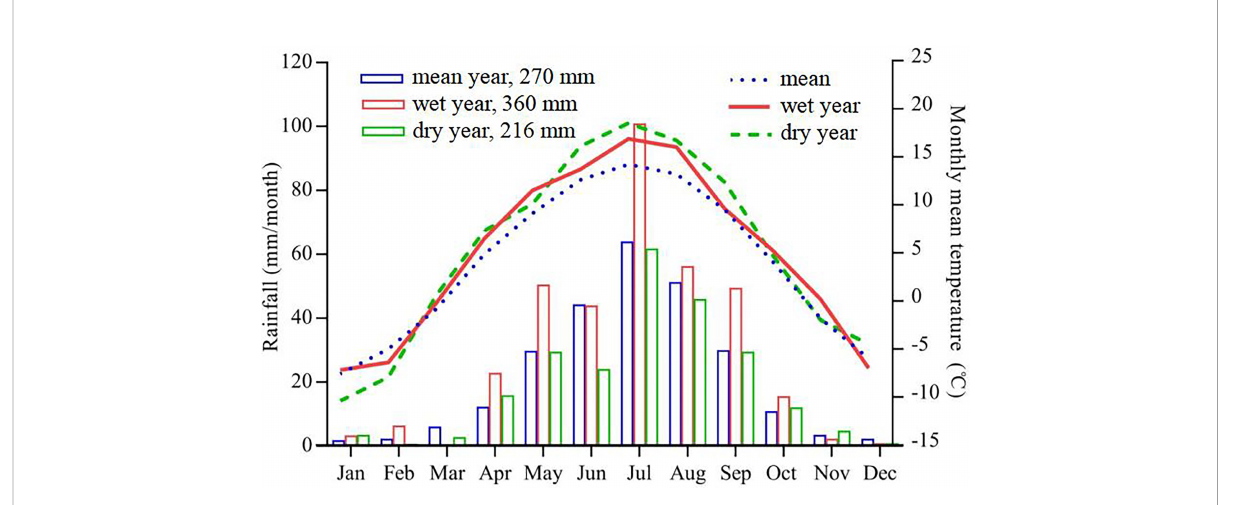
FIGURE 1 The monthly temperature (right Y-axis), and rainfall ( left Y-axis) at the study site on the alpine grassland over 34 years